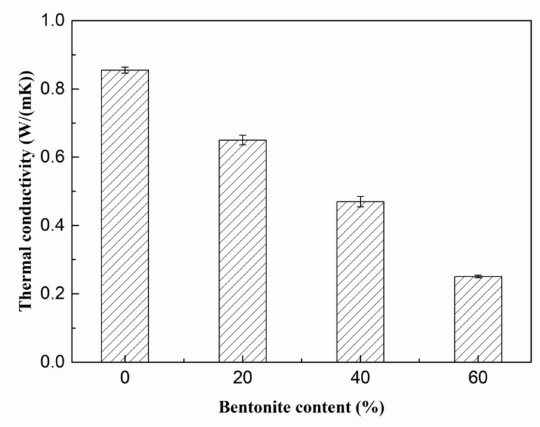
Figure 14. Thermal conductivity of porous samples.